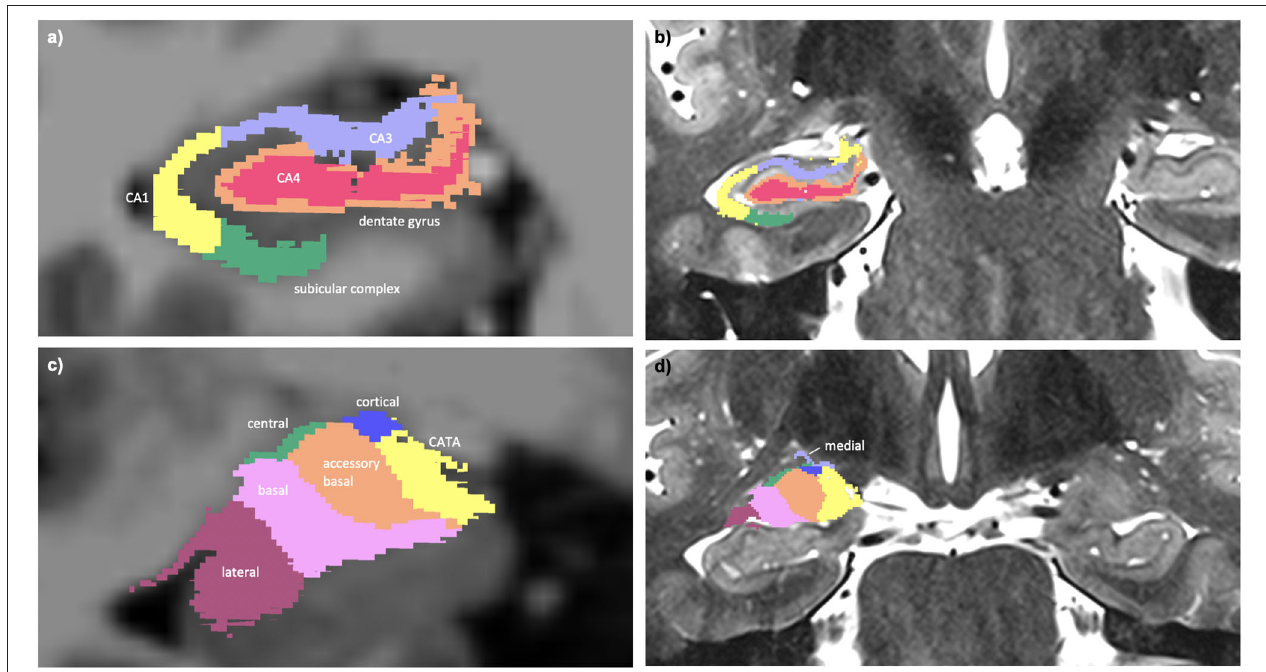
FIGURE 1 | (a) Multi-spectral hippocampal subfield segmentation (CA1, CA3, CA4, dentate gyrus, and subicular complex) with underlay of axial T1-weighted data. (b) Hippocampal subfield segmentation with underlay of axial T2-weighted data. (c) Multi-spectral amygdala subnuclei segmentation (lateral, basal, accessory basal, central, cortical, medial nuclei, and corticoamygdaloid transition area (CATA) with underlay of axial T1-weighted data. (d) Amygdala subnuclei segmentation with underlay of axial T2-weighted